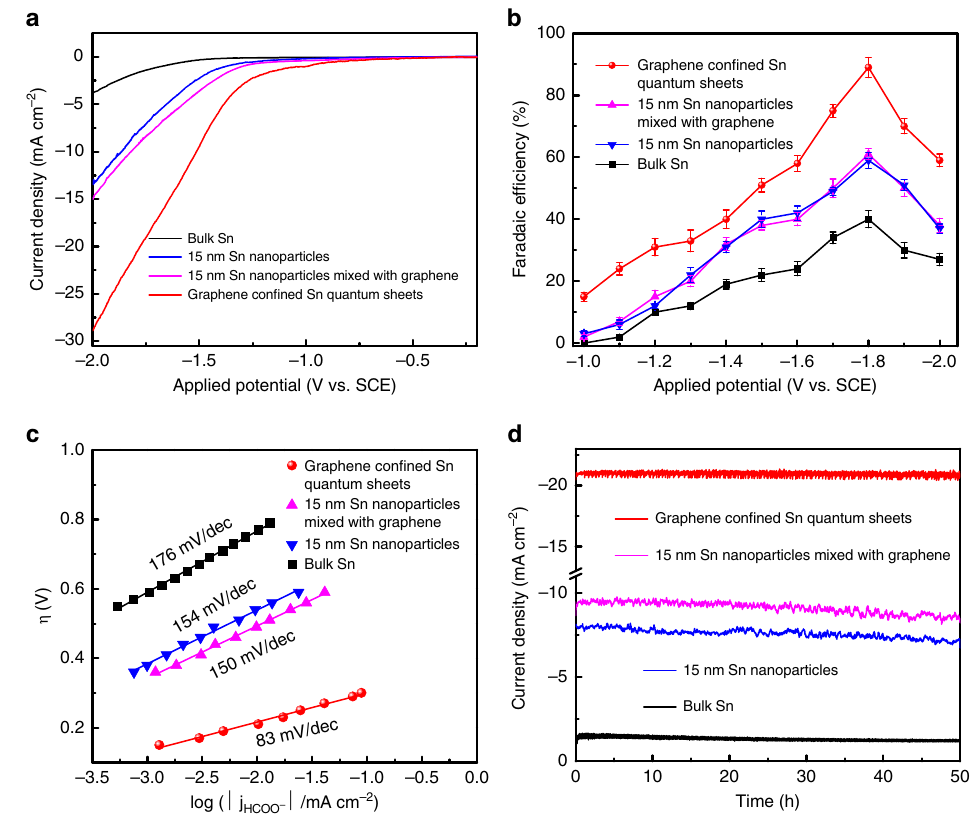
Figure 4 | CO 2 electroreduction performances. ( a ) Linear sweep voltammetric curves in the CO 2 -saturated 0.1M NaHCO 3 aqueous solution, ( b ) Faradaic efficiencies for formate at each applied potentials for 4h, ( c ) Tafel plots for producing formate, ( d ) Chrono-Amperometry results at the potentials of (cid:2) 1.8V versus SCE for the Sn quantum sheets confined in graphene, 15nm Sn nanoparticles mixed with graphene, 15nm Sn nanoparticles and bulk Sn. The error bars in b represent the standard deviations of five independent measurements of the same